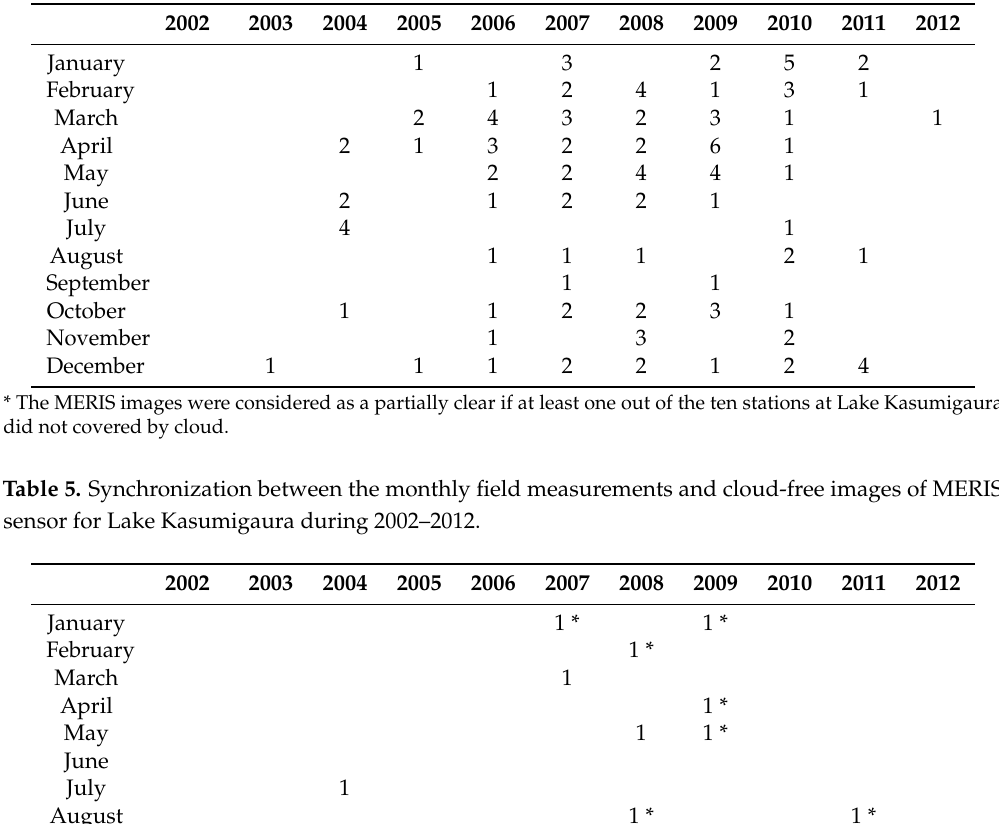
Table 4. Summary of clear and partially clear * images of MERIS sensor over Lake Kasumigaura between 2002 and 2012.